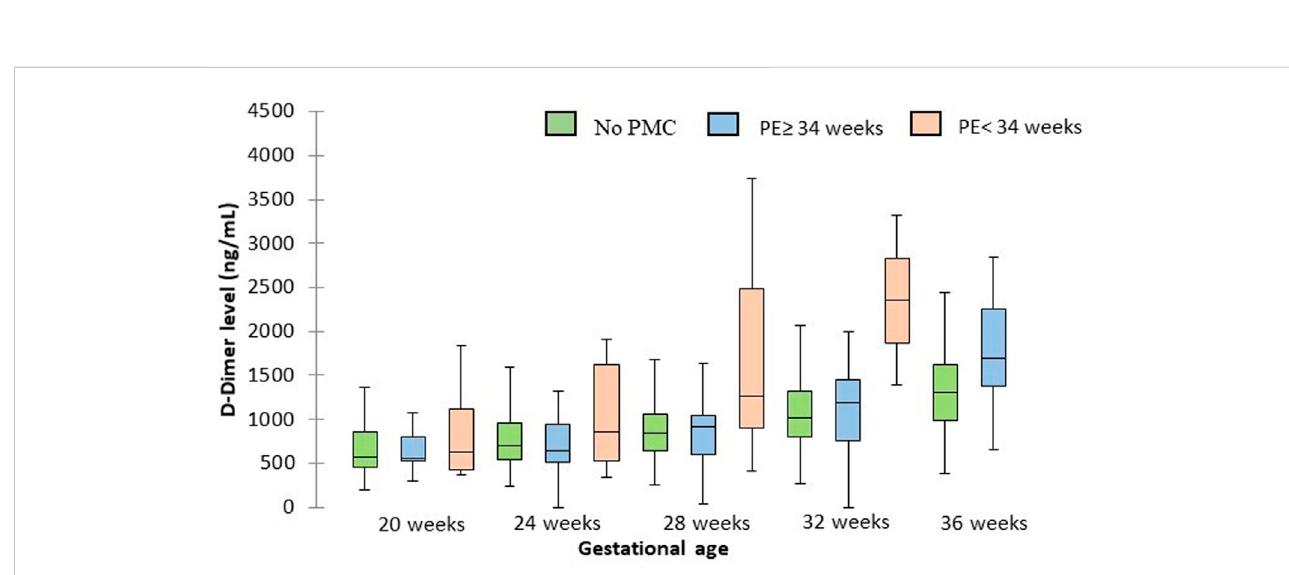
FIGURE 4 D-dimerlevelsateachgestationalageforpatientswithearlyandlatePEandforuncomplicatedpatients.Thecentralhorizontalbarsarethemedians.The lower and upper limits of the boxes are the fi rst and third quartiles. PMC: placenta-mediated